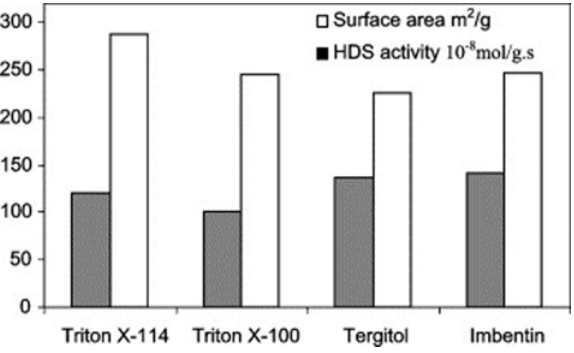
Figure 7. Thiophene HDS rate constants measured at 573 K and surface areas of the pre-catalysts prepared using different surfactants grades. Reproduced from reference [60] with permission from